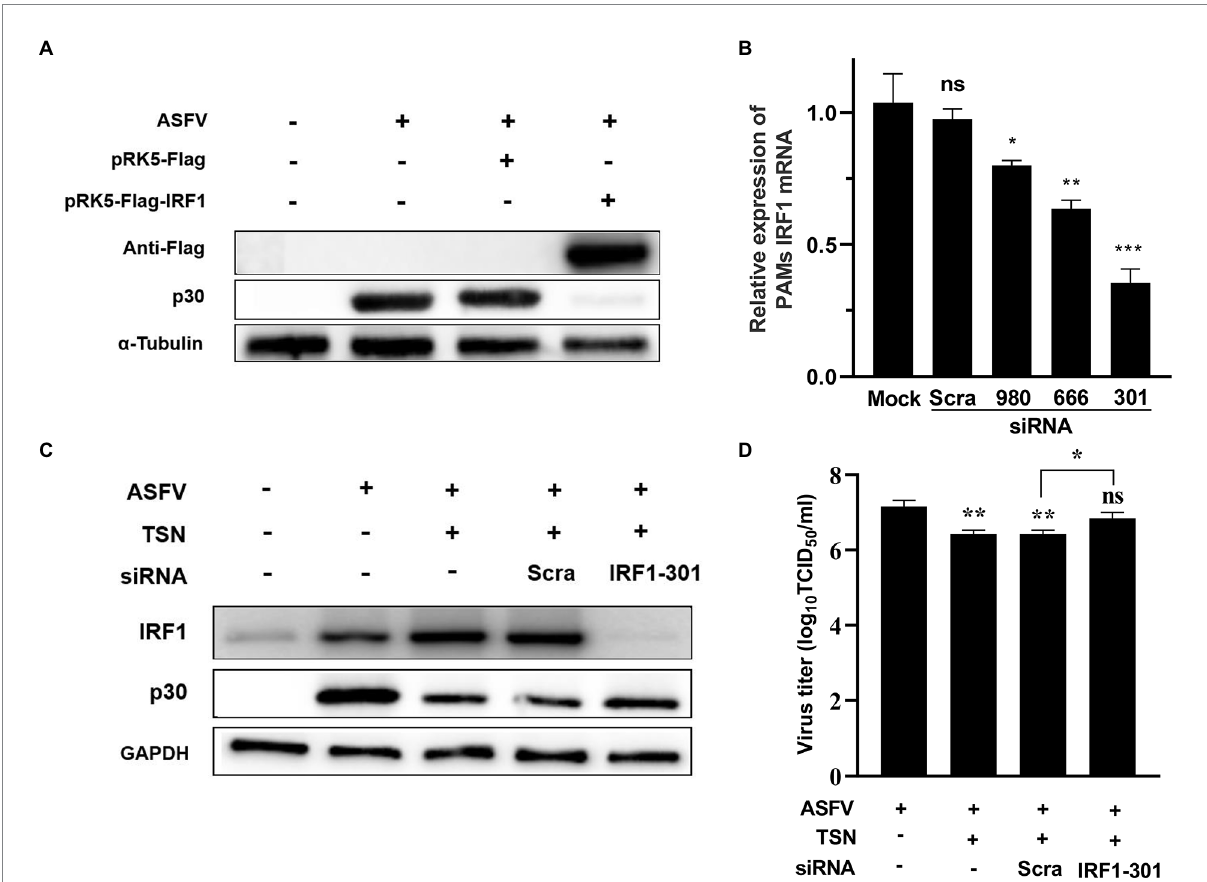
FIGURE 11 TSN suppresses ASFV replication via upregulating IRF1 expression. (A) PK-15 cells were challenged with 0.014 MOI ASFV at 37 ° C for 2 h, then PRK5- FLAG-IRF1 was transfected into PK15 cells at 37 ° C for 6 h. After that, the supernatant was discarded and the cells were washed with PBS. Then fresh maintenance medium was added in PK-15 cells and incubated at 37 ° C for 16 h. The samples were harvested at 16 h post transfection for Western Blot. (B) PAMs were transfected with 2 μ g/ml of three different siRNA against IRF1 and scramble siRNA (siRNA-Scra) at 37 ° C for 4 h. After that, the supernatant was discarded and the cells were washed with PBS, then fresh maintenance medium was added in PAMs. IRF1 was detected by RT-qPCR at 24 h post siRNA transfection. (C) PAMs were challenged with 0.014 MOI ASFV at 37 ° C for 2 h, then the siRNA-IRF1-301 or siRNA- Scra was transfected into PAMs at 37 ° C for 6 h. After that, the supernatant was discarded and the cells were washed with PBS followed by treatment with 1 μ M TSN. After culture at 37 ° C for 16 h, the samples were collected for Western Blot. (D) The samples from panel (C) were collected for endpoint dilution method analysis. *** denotes p < 0.001; ** denotes p < 0.01; * denotes p < 0.05. ns denotes no significant